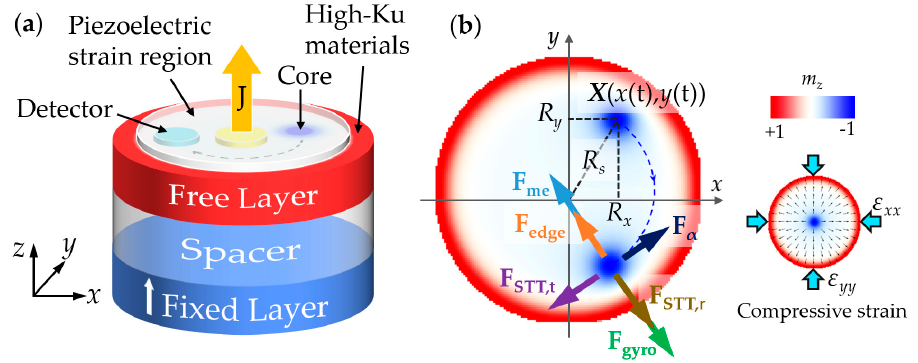
Figure 1. ( a ) Structural model of the STNO based on radial vortex; ( b ) top-view schematic diagram of an analysis of the different forces on the radial vortex core during gyration.